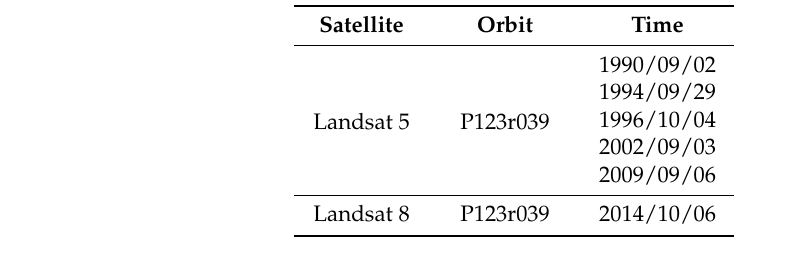
Table 1. Landsat images used in this study.